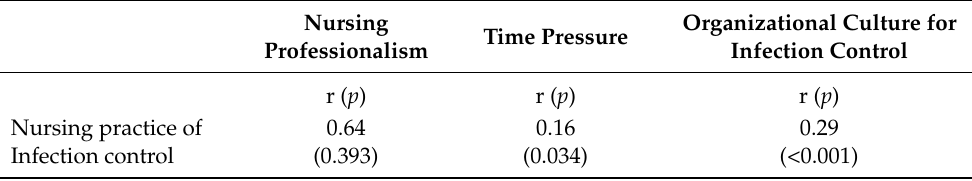
Table 3. Correlation among the Study Variables ( N =